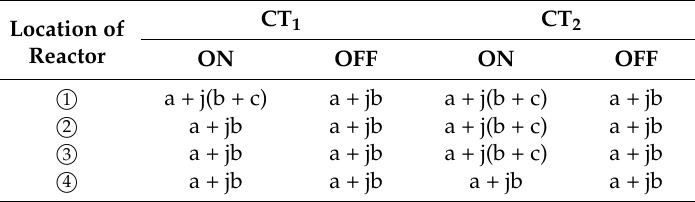
Figure 4. Example of re-coordination of overcurrent relay (OCR) due to installing the reactor. Table 1. CT currents according to locations of the reactor. Location of Reactor